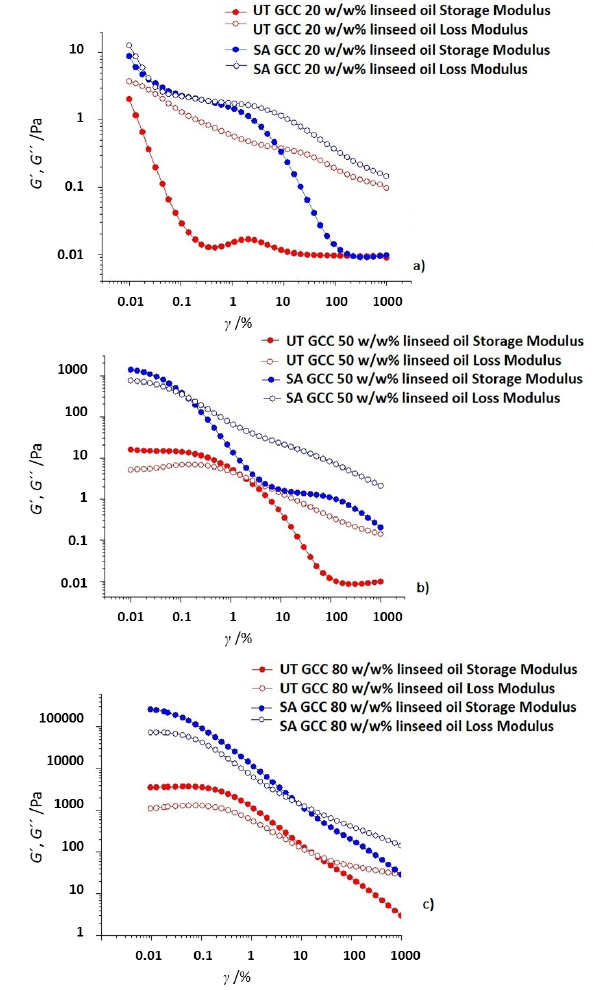
Figure 2: Viscoelastic properties, G ′ storage and G ′′ loss moduli, under strain, 𝛾 = 0.01 – 1 000% at constant angular frequency, ω = 0.1 s −1 (rad · s −1 ): (a) 20 w/w%, and (b) 40 w/w% and 50 w/w% solids content.